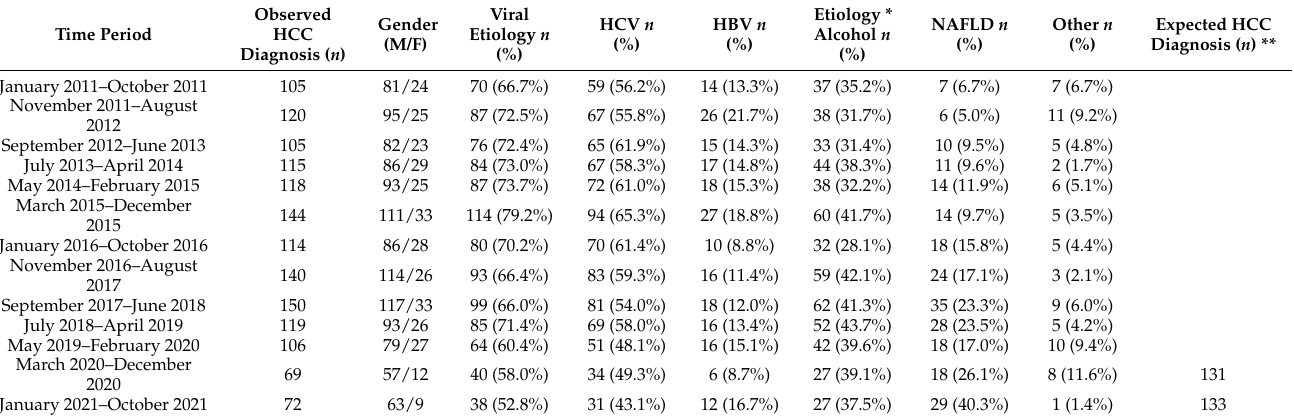
Figure 1. Number of HCC diagnoses per 10-month interval from 1 January 2011 to 31 October 2021. Regression equation: y = 111.527 + 0.165 ∗ x . The regression line is depicted in blue, while the 95% confidence interval of the regression line is depicted in red. Green dots indicate the number of patients diagnosed with HCC between January 2011 and February 2020, while the red dots indicate the number of patients diagnosed with HCC from March 2020 to October 2021. Abbreviations: coronavirus disease 19 (COVID-19), hepatocellular carcinoma (HCC), number ( n ). Table 2. Numbers of observed and expected diagnoses of HCC from 1 January 2011 to 31 November 2021.